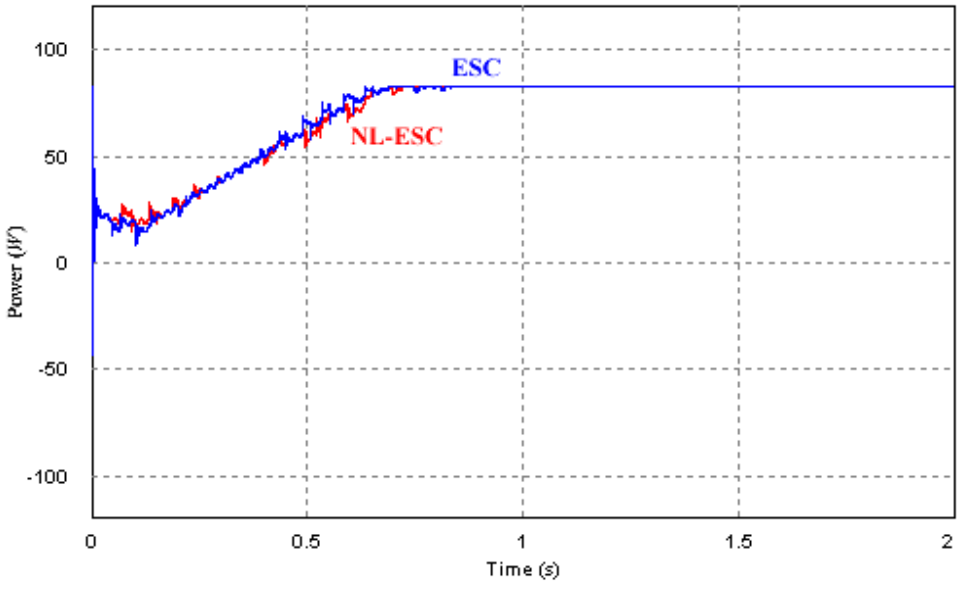
= 0.8 in NL-ESC case ( Red ); i = 0.8 in ESC case ( Blue i